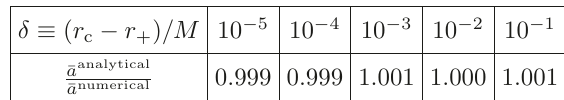
Table 5 . Marginally-stable spinning exotic compact objects. We display, for various values of the compactness parameter δ ≡ ( r max − r + ) /M introduced in [13], the dimensionless ratio c ¯ a analytical ( δ ) / ¯ a numerical ( δ ) between the analytically derived critical angular momentum which char- acterizes the marginally-stable spinning exotic compact object and the corresponding numerically computed [13] value of the critical rotation parameter. The data presented are for the fundamental ( n = 1) resonances of the spinning exotic compact objects with reflecting Dirichlet boundary condi- tions and for a massless scalar field mode with l = m = 1. One finds a remarkably good agreement between our analytical results and the corresponding numerical data of